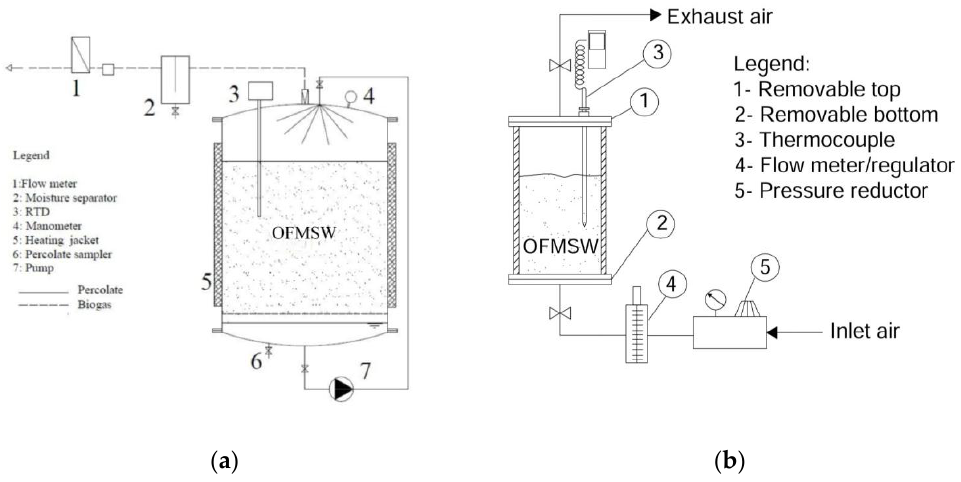
Figure 1. Scheme of the ( a ) solid anaerobic digestion batch (SADB) and ( b ) aerobic pilot-scale